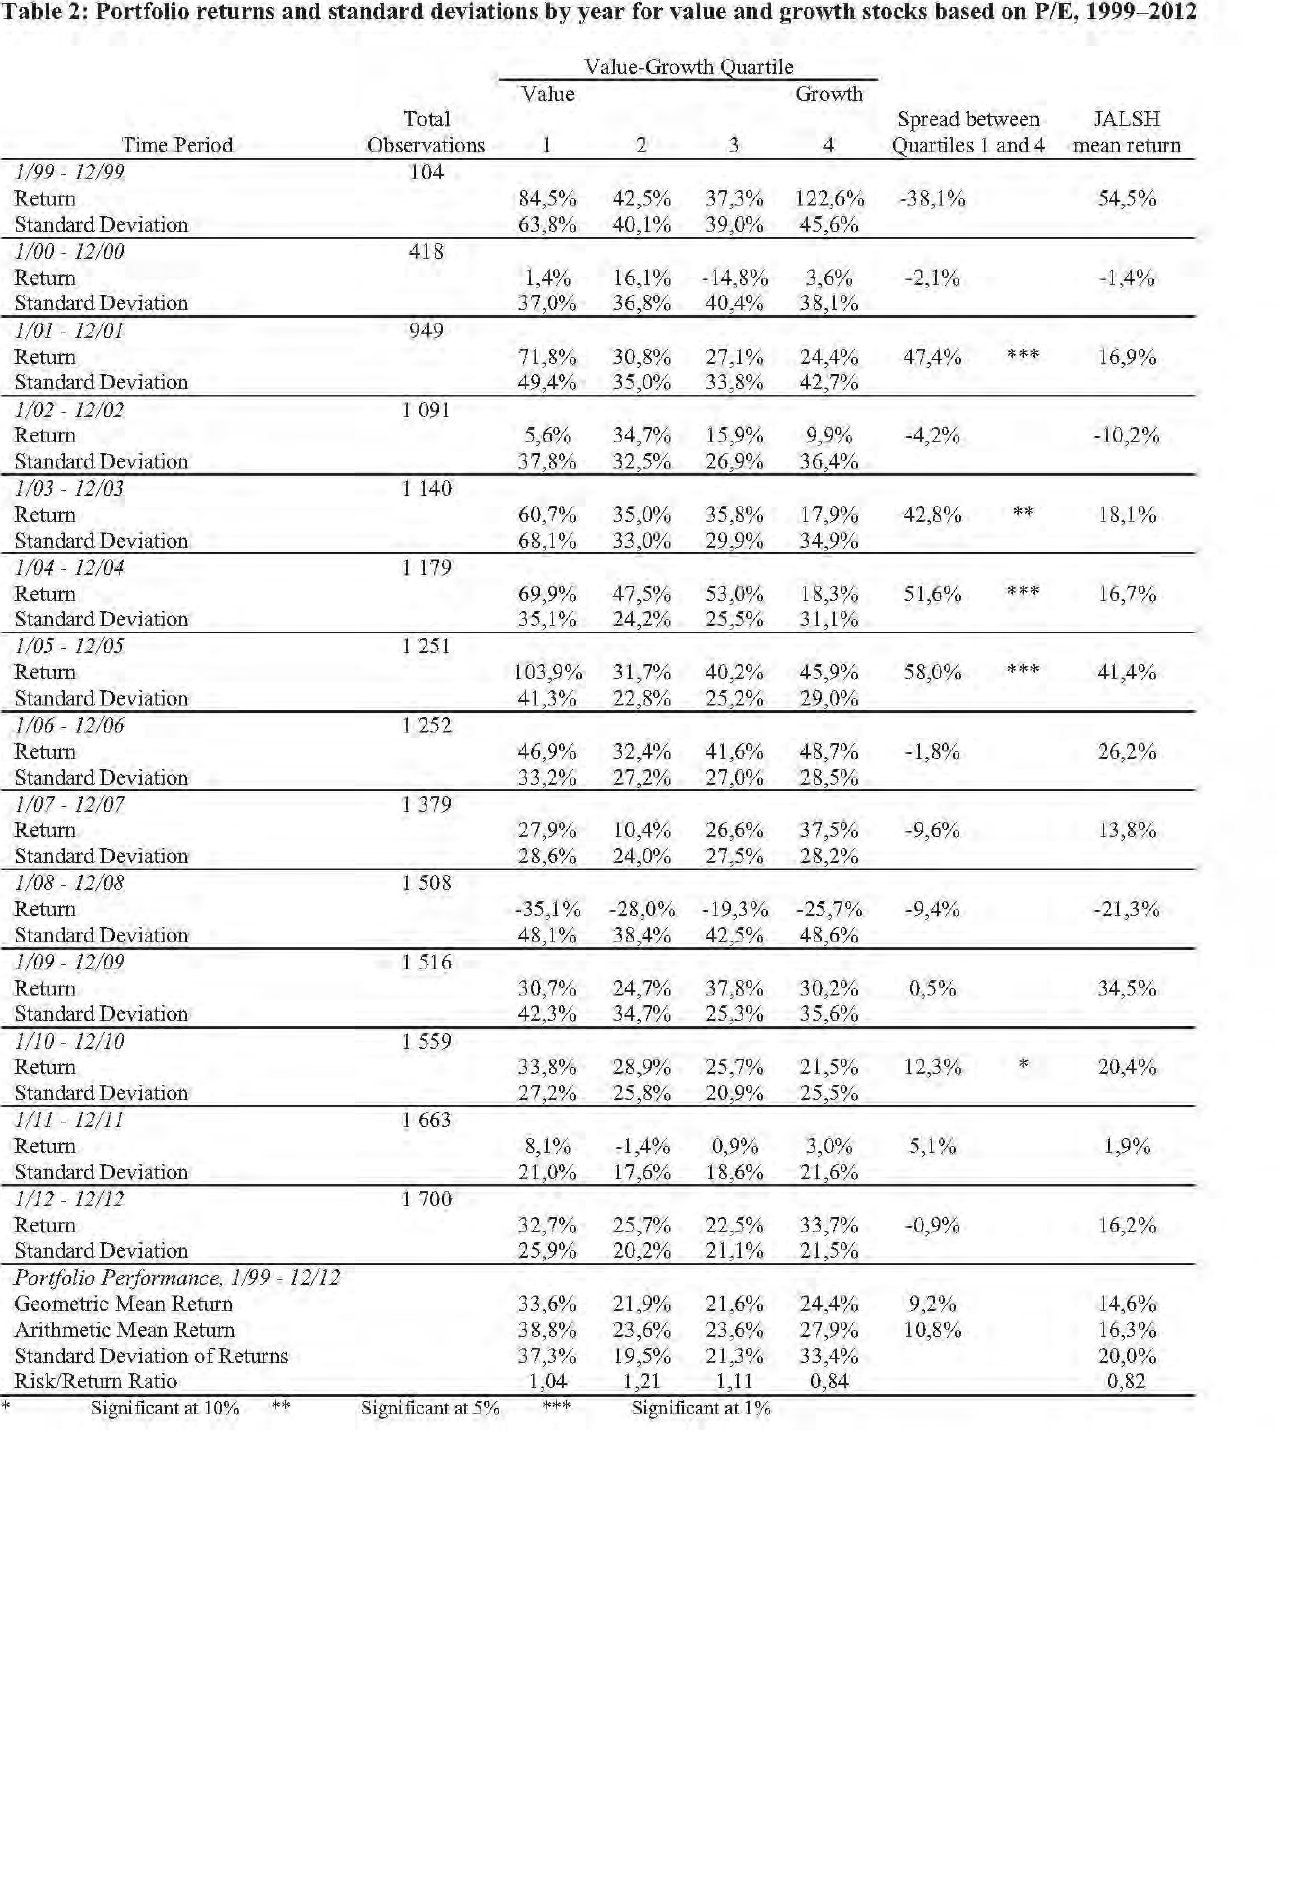
Table 2: Portfolio returns and standard deviations by year for value and growth stocks based on PIE, 1999-2012 Value-Growth